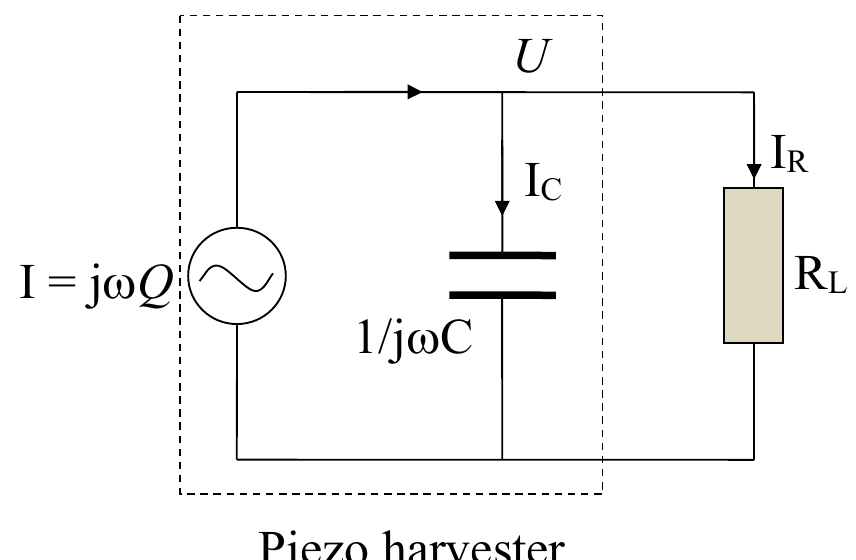
Figure 3. Equivalent circuit of an energy harvester.